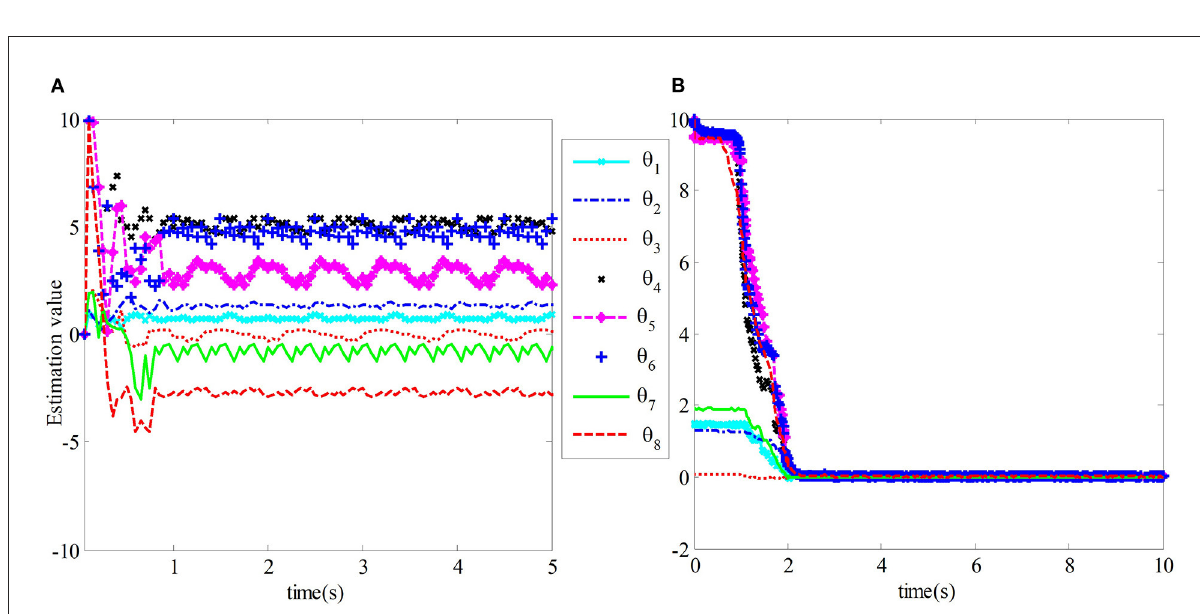
FIGURE8 The estimation error of θ s of the slave robot dynamic parameter vector. (A) The estimation error of TAC. (B) The estimation error of